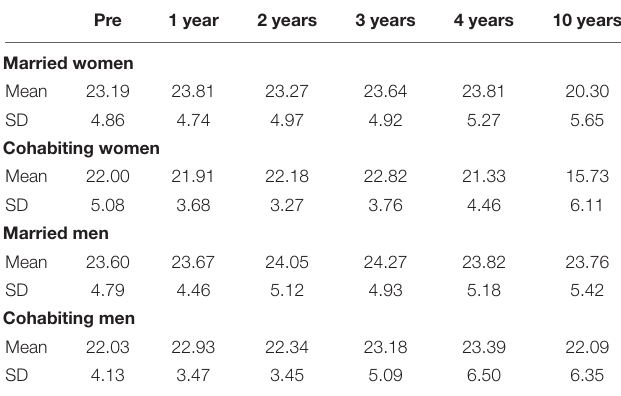
TABLE 2 | Relationship adjustment of those couples who stayed together over the 10 Years. Pre